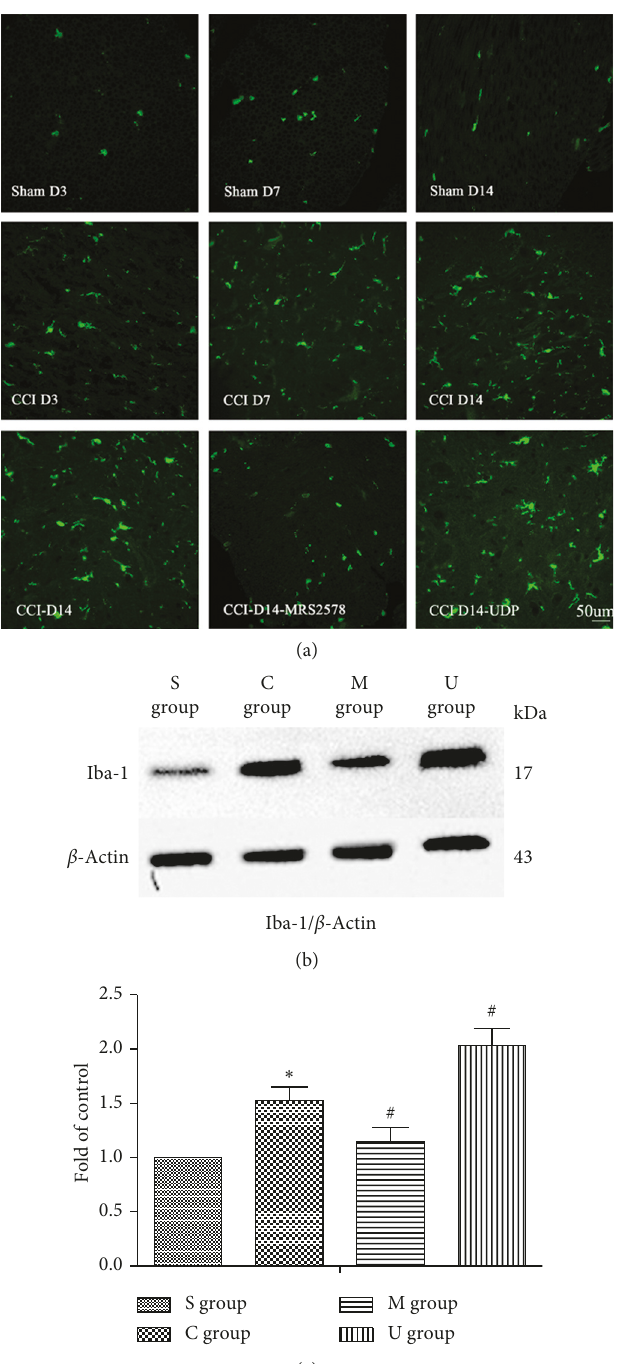
Figure 2: Manipulation of the P2Y6 receptor led to changes in marker of spinal microglial activation in CCI rat models. (a) Representative immunostaining pictures showing the expression of Iba-1 in the L4-5 spinal dorsal horn on days 3, 7, and 14 postsurgery between the CCI and sham group, as well as Iba-1 immunostaining on day 14 among CCI, MRS2578+CCI, and UDP+CCI. (b) Expression of Iba1 protein in the spinal cord of sham, CCI, MRS2578+CCI, and UDP+CCI rats on day 14 after surgery quantified by mean ± SEM of integrated optical density (IOD) of Iba1/ β -actin in rats on day 14 after surgery, n � 4. S: sham operated rats; C: CCI rats; M: CCI rats treated with MRS2578; U: CCI rats treated with UDP. Significance of Iba1 levels were analyzed with one-way ANOVA followed by the Student–Newman–Keuls post hoc test ( ∗ P < 0 . 05, vs the sham group; # P < 0 . 05, vs the CCI